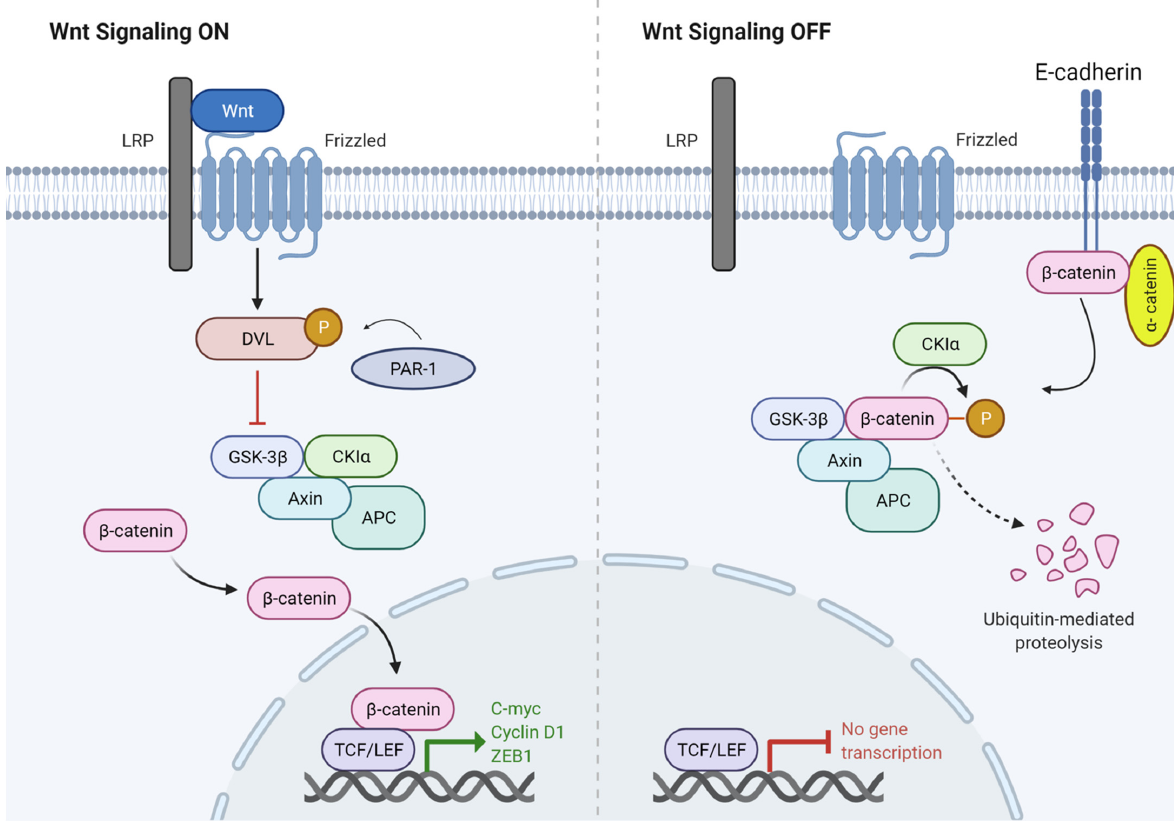
Figure 2. The canonical Wnt signalling pathway. Wnt binding causes inhibition of the GSK3-CK1 α -APC-Axin complex through dishevelled protein (DVL). DVL gets activated by phosphorylation through PAR-1. As a result of the inhibition activity, free β -catenin accumulates in the cytoplasm and then translocates to the nucleus to mediate the transcriptional activation of oncogenic target genes such as cyclin D1, C-MYC and ZEB1. In absence of Wnt ligands, β -catenin is bound to E-cadherin as a part of adherens junction complex. The β -catenin destruction complex composed of Axin, GSK3, CK1 α and APC causes phosphorylation of β -catenin through GSK3 and CK1 α leading to proteasomal degradation of β -catenin.